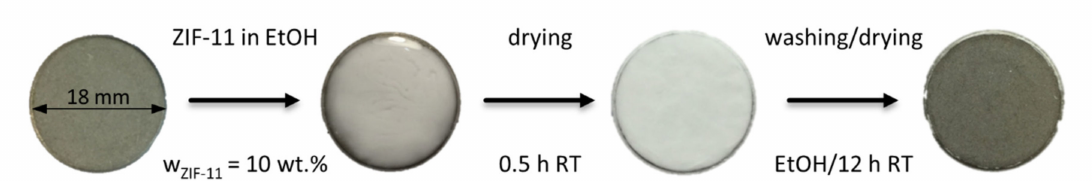
Figure 3. Images of a support (symmetric stainless steel, Mott Corporation) at different stages during drop seeding and typical parameters of drop